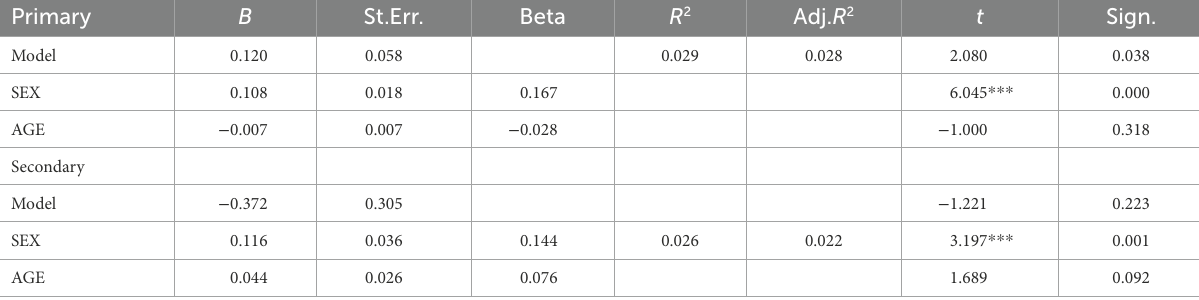
TABLE 4 Linear regression model: sex and age as predictors of negative outcomes in primary and secondary school children. Primary B St.Err.